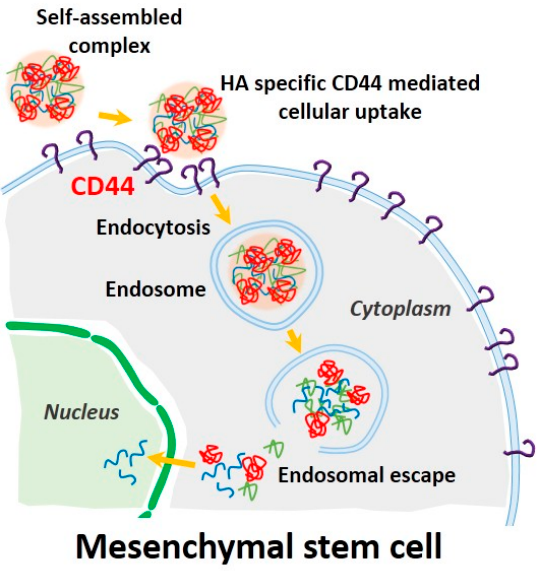
Figure 8. Schematic illustration of CD44-mediated endocytosis and delivery of pDNA into a stem cell using our self-assembled complexes. (Blue line: plasmid DNA, green line: PEI, red line: HA).